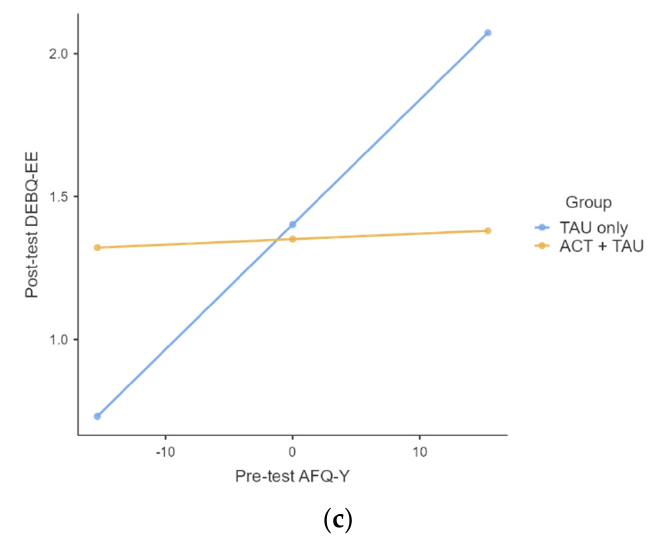
Figure 3. Moderation effects. ( a ) Moderation effect of group in the relationship between depression and emotional eating. Note: DASS-D: Depression subscale of the Depression Anxiety and Stress scale; DEBQ-EE: Emotional Eating subscale of the Dutch Eating Behavior Questionnaire. ( b ) Moderation effect of group in the relationship between stress and emotional eating. Note: DASS-S: Stress subscale of the Depression Anxiety and Stress scale; DEBQ-EE: Emotional Eating subscale of the Dutch Eating Behavior Questionnaire. ( c ) Moderation effect of group in the relationship between